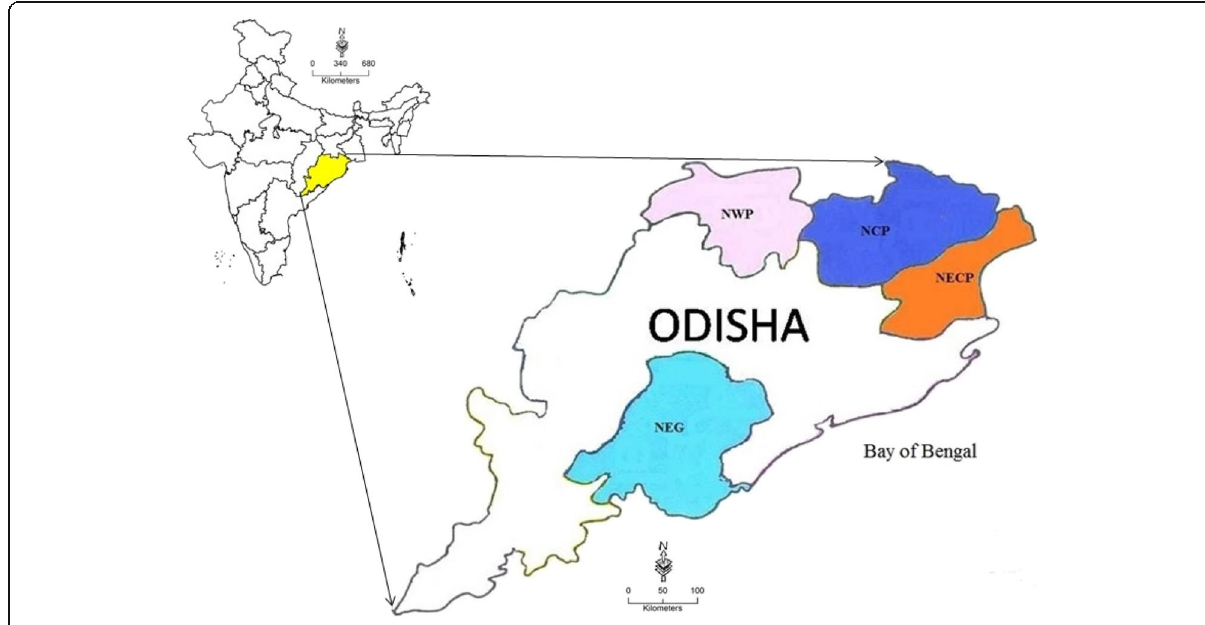
Fig. 1 Map showing study area in eastern India